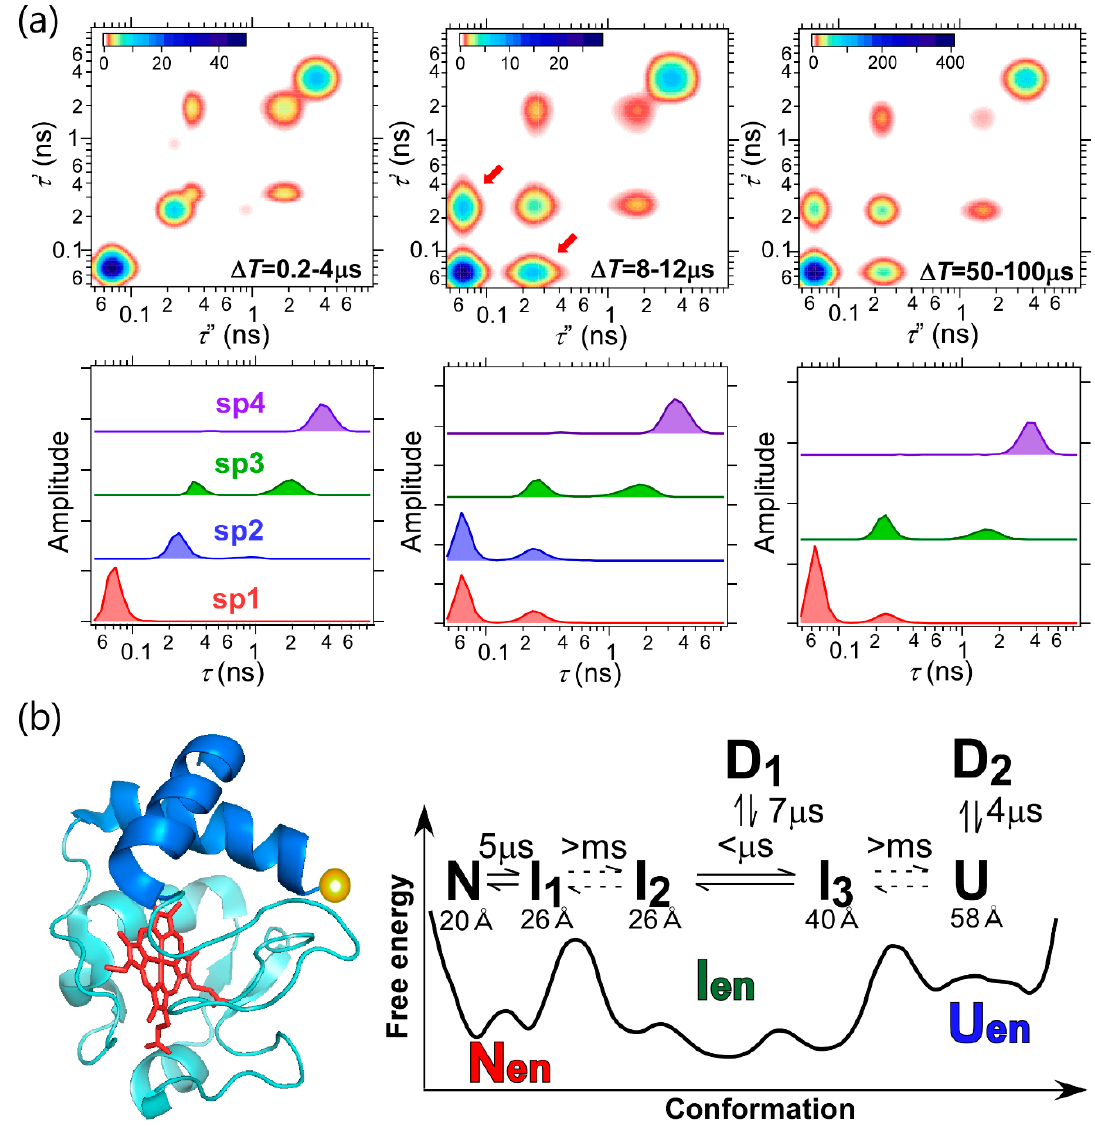
Figure 5. 2D FLCS of cytochrome c . ( a ) 2D lifetime correlation maps at ∆ T = 0.2–4, 8–12, and 50–100 µ s (upper) and the corresponding independent lifetime distributions (lower). ( b ) (left) Native-state structure of cytochrome c (PDB ID:1YCC). N- and C-terminal helices are highlighted with blue. The position of the donor dye is shown by a yellow sphere. (right) Schematic free-energy landscape and the relevant conformational dynamics of cytochrome c at pH 3.5. The equilibration times among conformers and the donor–heme distances evaluated in the present work are given. Adapted with permission from Macmillan Publishers Ltd.: Nature Communications Ref. [37], Copyright 2015.